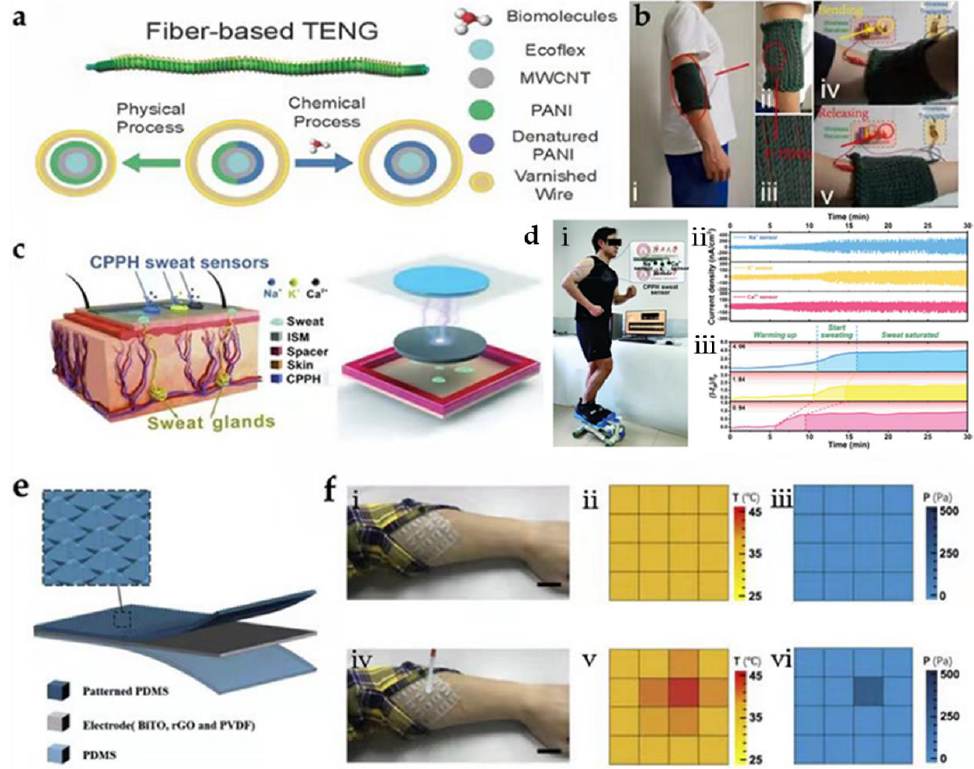
Figure 2. Applications of wearable TENG − based biosensors for body condition monitoring. ( a ) The structure of a single TENG. ( b ) Smart clothing integrated with TENG (i–v). Insets iv and v show a wireless control system integrated with TENG. Reprinted/adapted with permission from Ref.